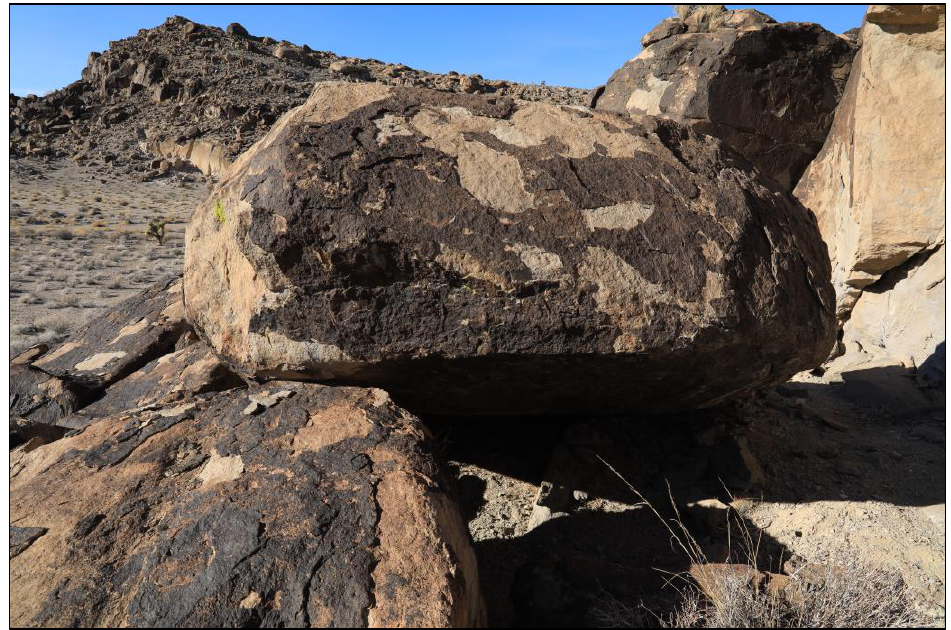
Figure 15. A large boulder against a cliff above the canyon (Source: Stoffle).